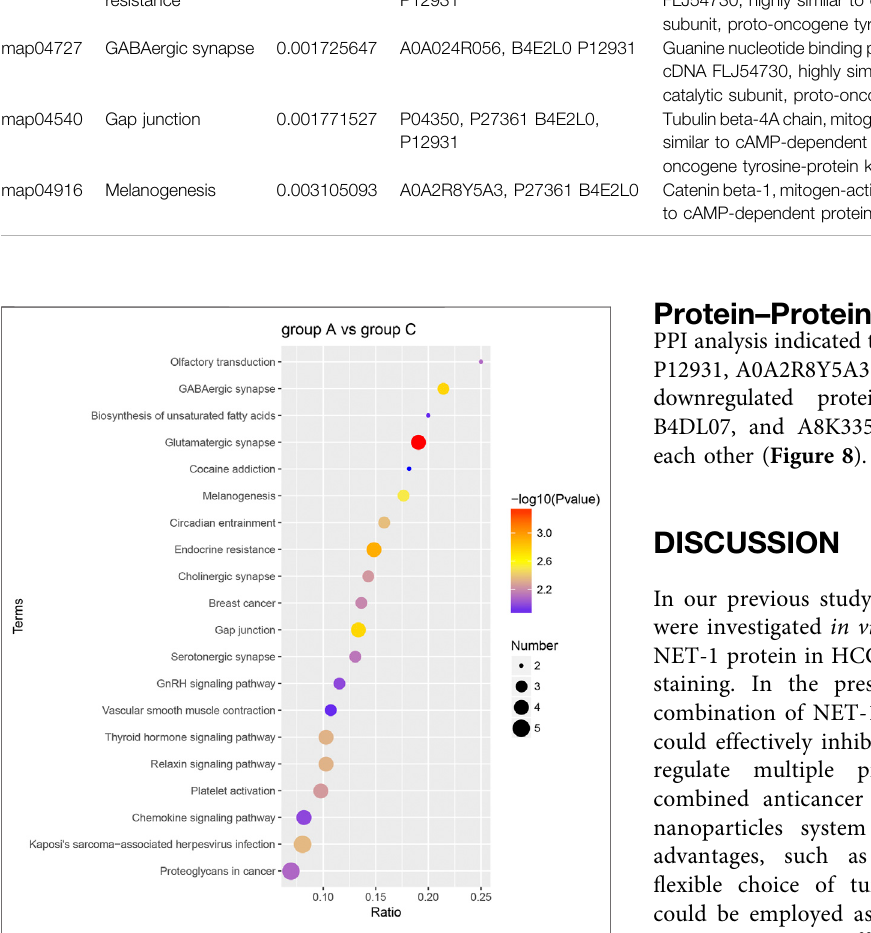
FIGURE 6 | KEGG pathway enrichment analysis of DEP. The top 20 KEGG enrichment terms of all DEP between group A and group C were shown in the scatter plot. The color of the dot represents the − log10 ( p -value), and the size of the dot represents the number of